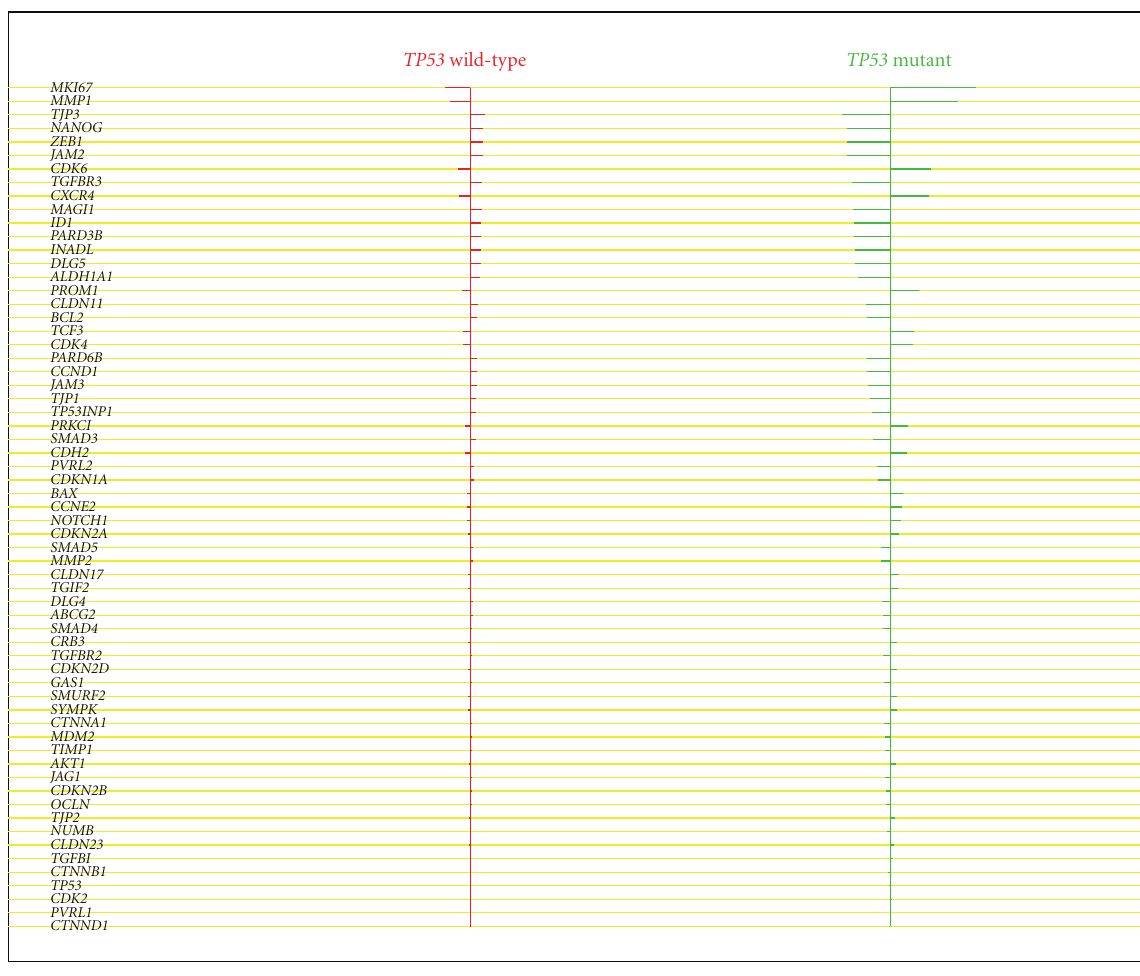
Figure 1: Shrunken centroids for wild-type TP53 and mutant TP53 tumors. Left-sided bars indicate lower expression in the subgroups relative to overall centroid; right-sided bars indicate higher expression in subgroups relative to overall centroid. polarity complex ( DLG4 , DLG5, INADL, PARD3B, PARD6B ) and apical junctional components ( CLDN11 , JAM2, JAM3, MAGI1, OCLN, PVRL2, TJP1, TJP3 ). Conversely,